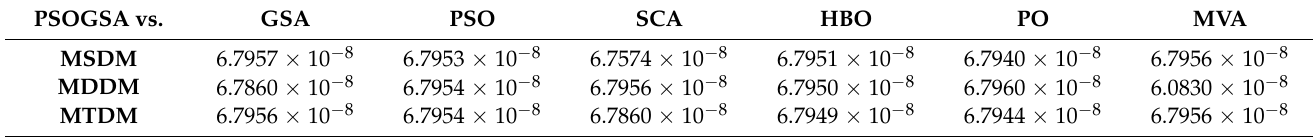
Table 10. Statistical results based on Wilcoxon’s rank sum test for the monocrystalline PV Cell. PSOGSA vs.